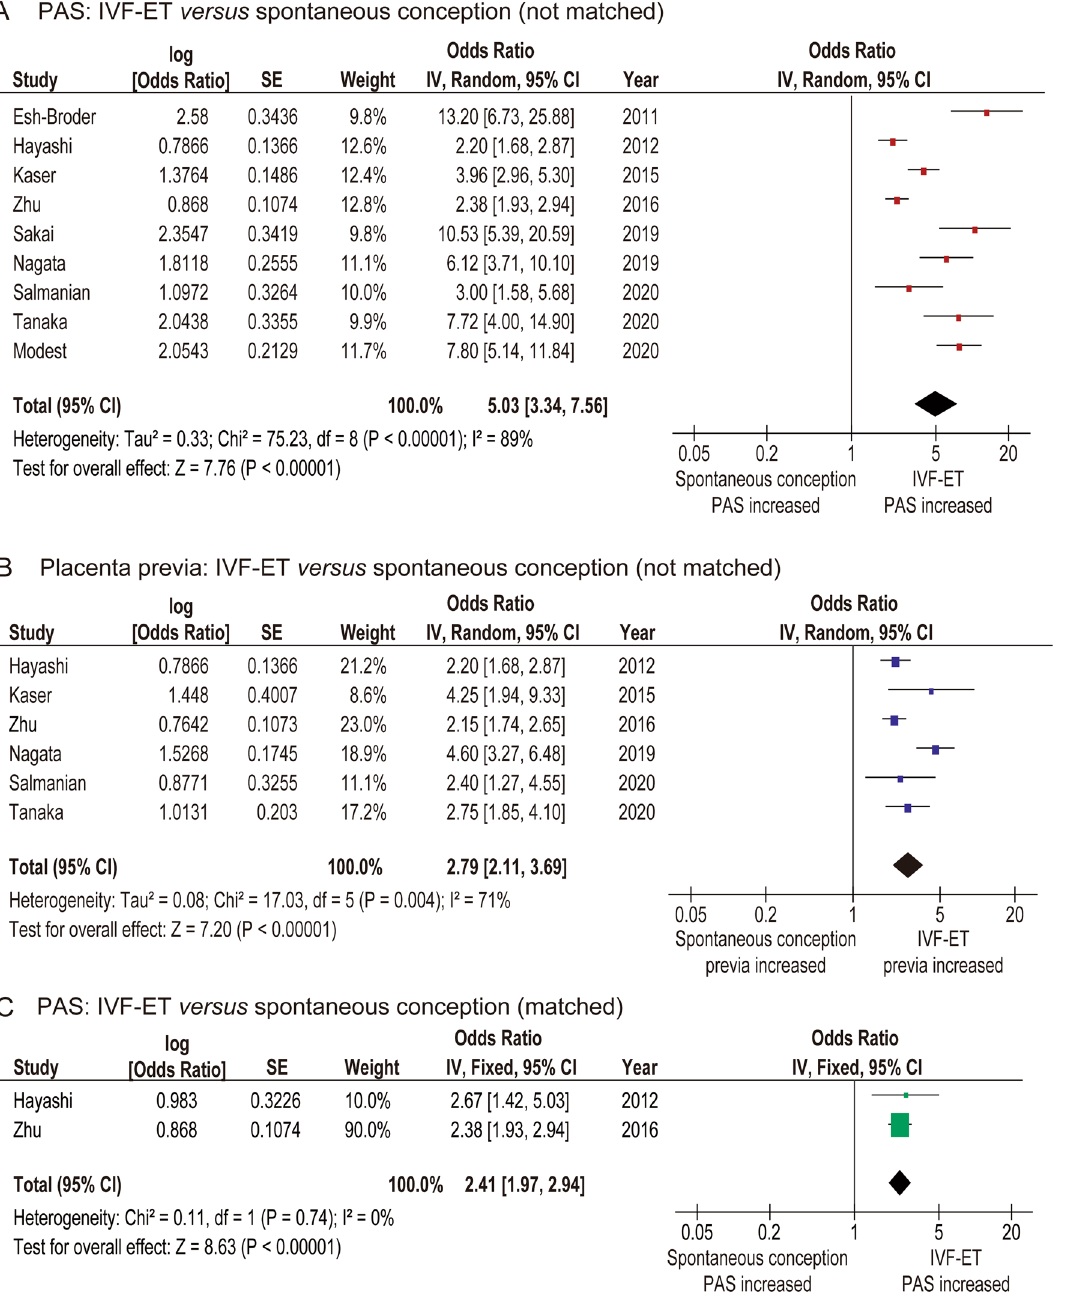
Figure 2. Results of the meta-analysis for the effect of IVF-ET on PAS. The pooled odds ratio for ( A ) PAS, ( B ) placenta previa, and ( C ) PAS (patient background matched) between IVF-ET patients versus spontaneous conception patients are shown. Since the numbers after the third decimal places for the lower or upper confidence interval were omitted in most studies, some calculated values of OR using Revman ver. 5.4.1™ may be different from the original values. Abbreviations: PAS, placenta accreta spectrum; OR, odds ratio; CI, confidence interval; and IVF-ET, in vitro fertilization-embryo